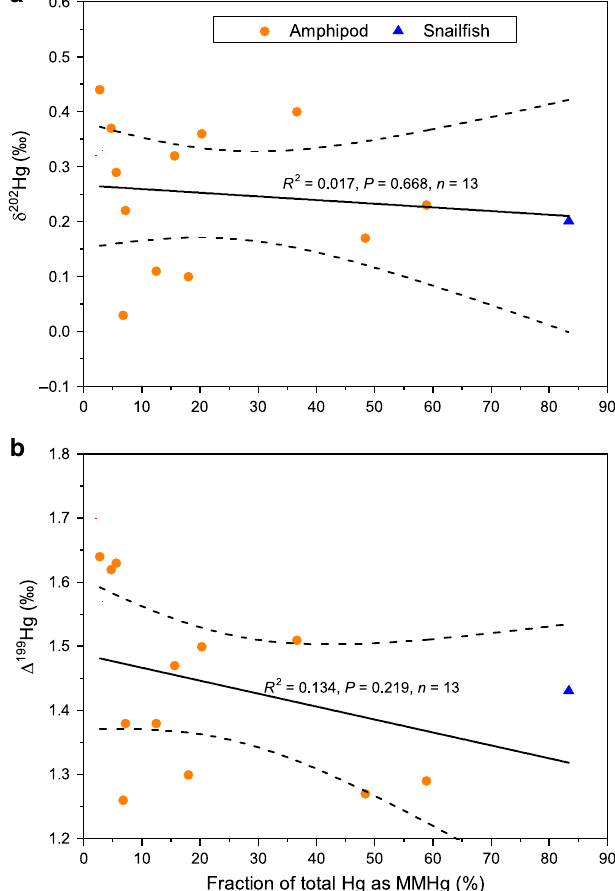
Fig. 3 Trench fauna δ 202 Hg, Δ 199 Hg and monomethylmercury fraction. Linear correlations of a δ 202 Hg versus monomethylmercury fraction (MMHg%), and b of Δ 199 Hg versus monomethylmercury fraction (MMHg %). The typical analytic uncertainty of our fauna samples was 0.08 ‰ (two standard deviation) for δ 202 Hg and 0.10 ‰ (two standard deviation) for Δ 199 Hg. n is the number of